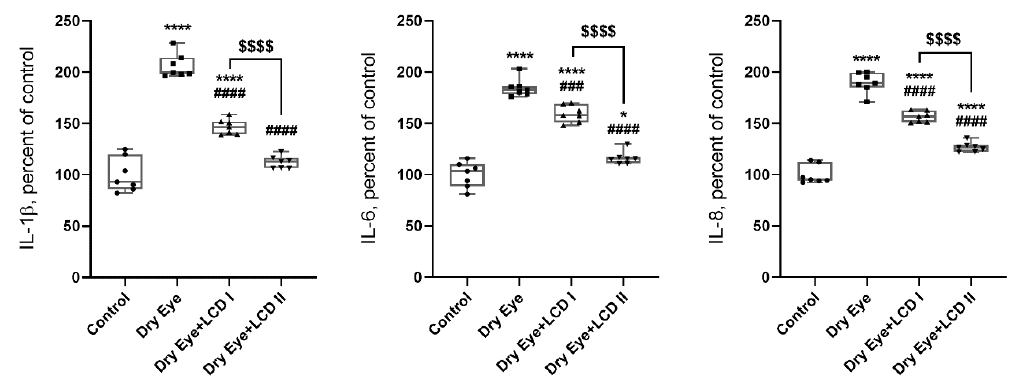
Figure 5. Effect of the combination of lutein/zeaxanthin, curcumin and vit D (LCD) on NF- κ B, TNF- α , IL-1 β , IL-6, and IL-8 protein levels in benzalkonium chloride (BAC)-induced dry eye syndrome in rats ( n = 7 per group). Control: No treatment; Dry Eye: BAC-induced dry eye syndrome; LCD I; Dry Eye + LCD I: BAC-induced dry eye syndrome plus LCD I (100 mg/kg body weight); Dry Eye + LCD II: BAC-induced dry eye syndrome plus LCD II (200 mg/kg body weight). Data are expressed as % of the control value. Western blot analysis (n = 3 at least) was performed with actin included to ensure equal protein loading. (ANOVA and Tukey ′ s post-hoc test. Statistical significance between groups is shown by: * p < 0.05; *** p < 0.001; **** p < 0.0001 compared as control group; ## p < 0.01; ### p < 0.001; #### p < 0.0001 compared as Dry Eye group; $ p < 0.05; $$$$ p < 0.0001 compared as Dry Eye + LCD I group).